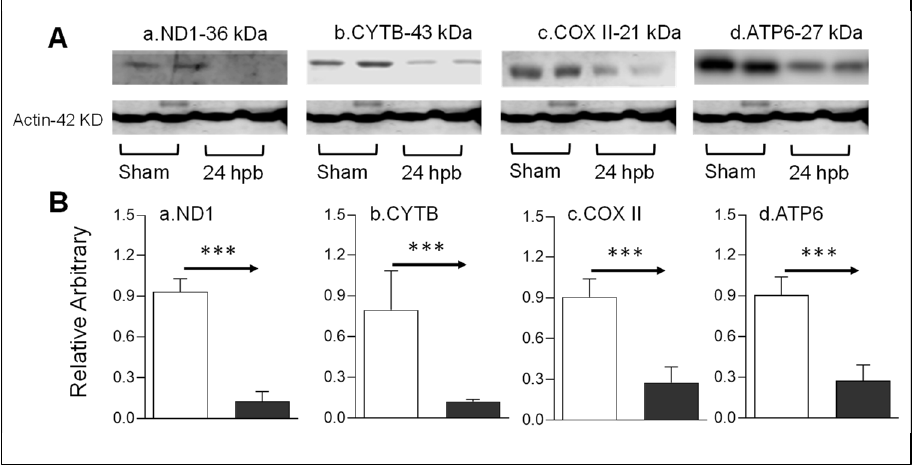
Figure 7. mtDNA replication and mtDNA-encoded gene expression in burned rats. Sprague Dawley rats were burned with boiling water and treated. Heart tissues were collected at 24 h post burn (24 dpb) to make the heart gDNAs, RNAs and cDNAs. qPCR was utilized to measure the mtDNA copy number and mtDNA-encoded 13 gene expressions. ( A ) the myocardial levels of the mt D-Loop copy number are shown; ( B ) panels a–g show representatives of gene expressions for the mtDNA-encoded complex I genes including ND1, ND2, ND3, ND4, ND4L, ND5 and ND6; ( C ) the mtDNA-encoded complex III gene, CYTB, is shown; ( D ) panels a–c show the mtDNA-encoded complex IV genes including COXI, COXII and COXIII; and ( E ) panels a,b show the gene expressions of mtDNA-encoded complex V genes including ATP6 and ATP8. In all figures, the data are presented as the mean value ± SD. Significance is shown as and presented as *** p < 0.001 (24 hpb vs. matched control, n = ≥ 6 per group).